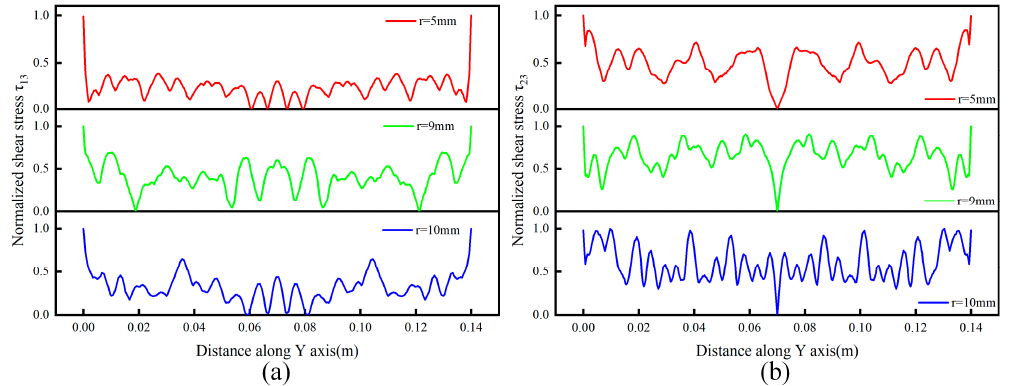
Figure 12. Normalized shear stress amplitude varies along the Y axis: ( a ) shear stress τ 13 ; ( b ) shear stress τ 23 .